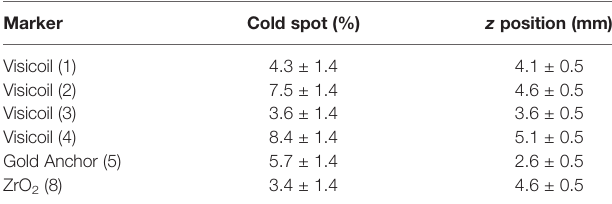
TABLE 10 | Maximum cold spot values and their position behind the fi ducial marker along the beam axis for 6 different markers ( Table 1 ), computed with FLUKA